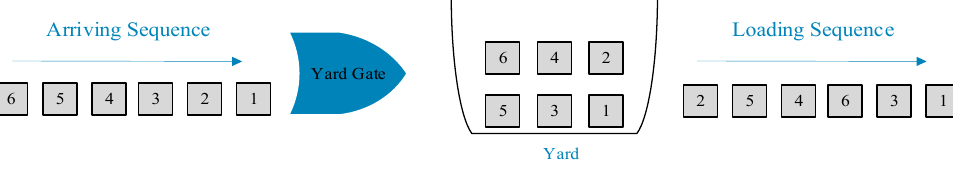
Figure 2. Example of container relocation in the yard.